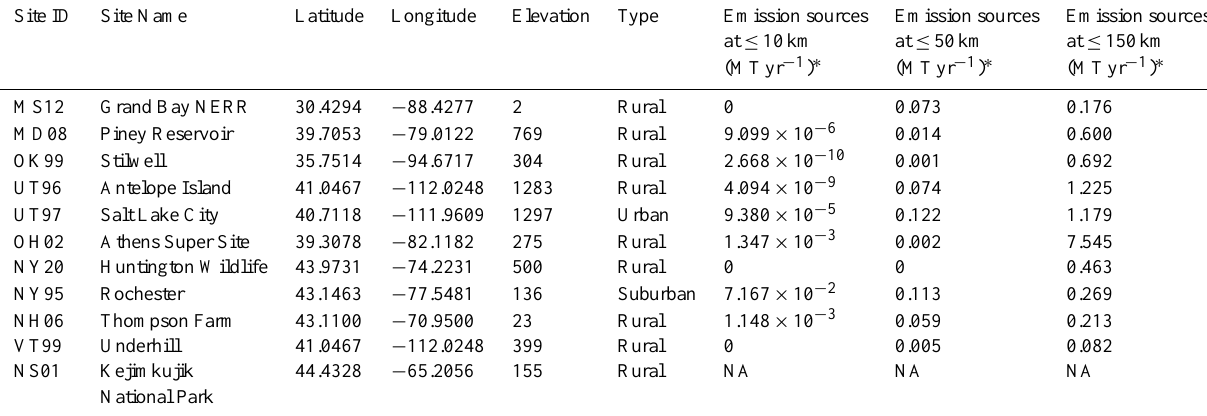
Table 1. Site description and mercury emission from nearby facilities. Site ID